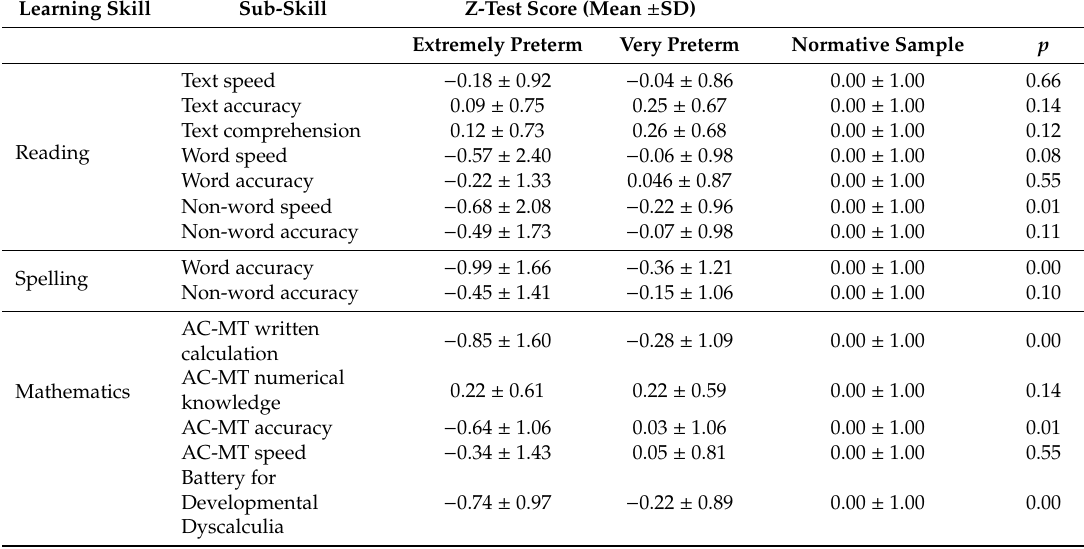
Table 3. Z-test scores for the learning skills of the extremely preterm and very preterm children. Learning